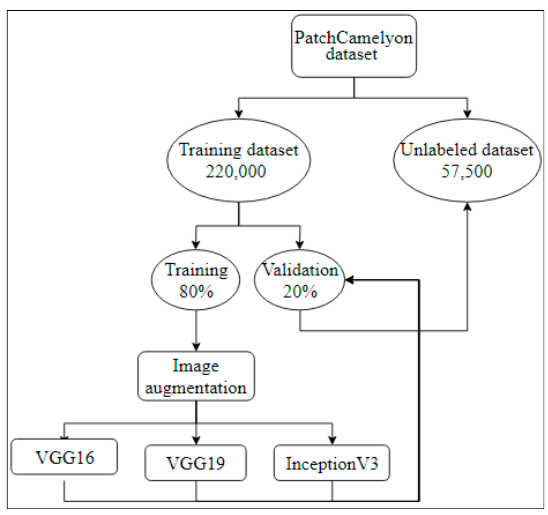
Figure 10. A schematic diagram of the proposed model.